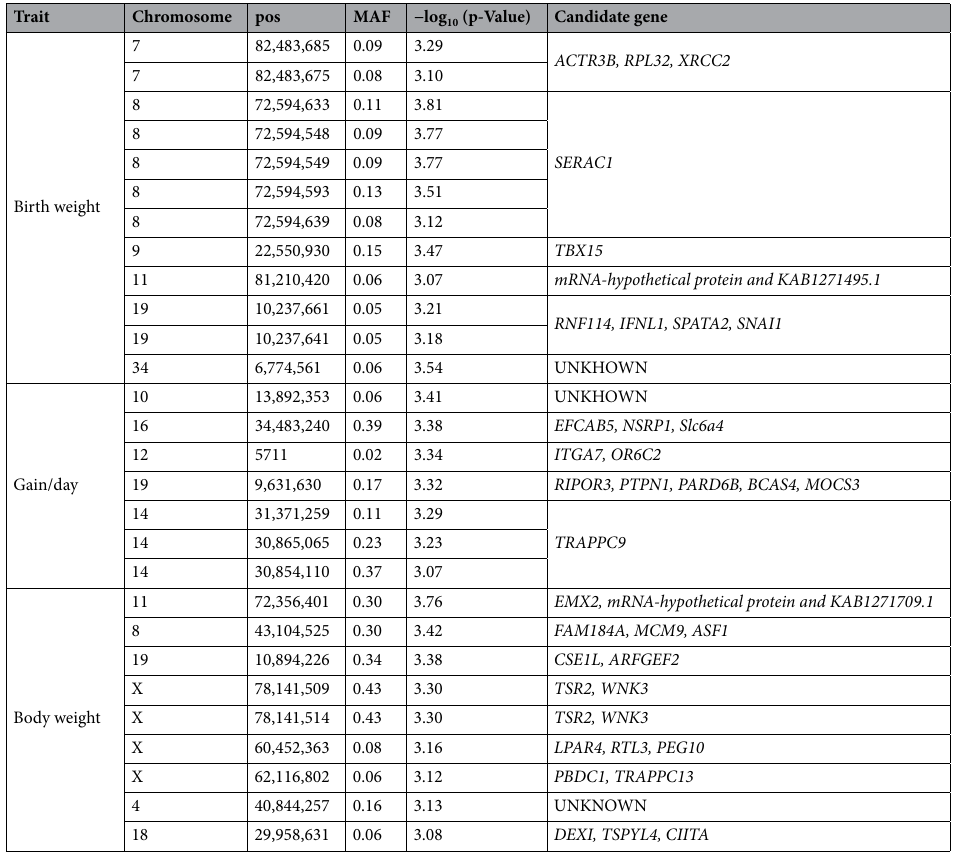
Table 4. Genome-wide association studies (GWAS)-identified significant single-nucleotide polymorphisms (SNPs) (− log p value > 3), associated traits, and candidate